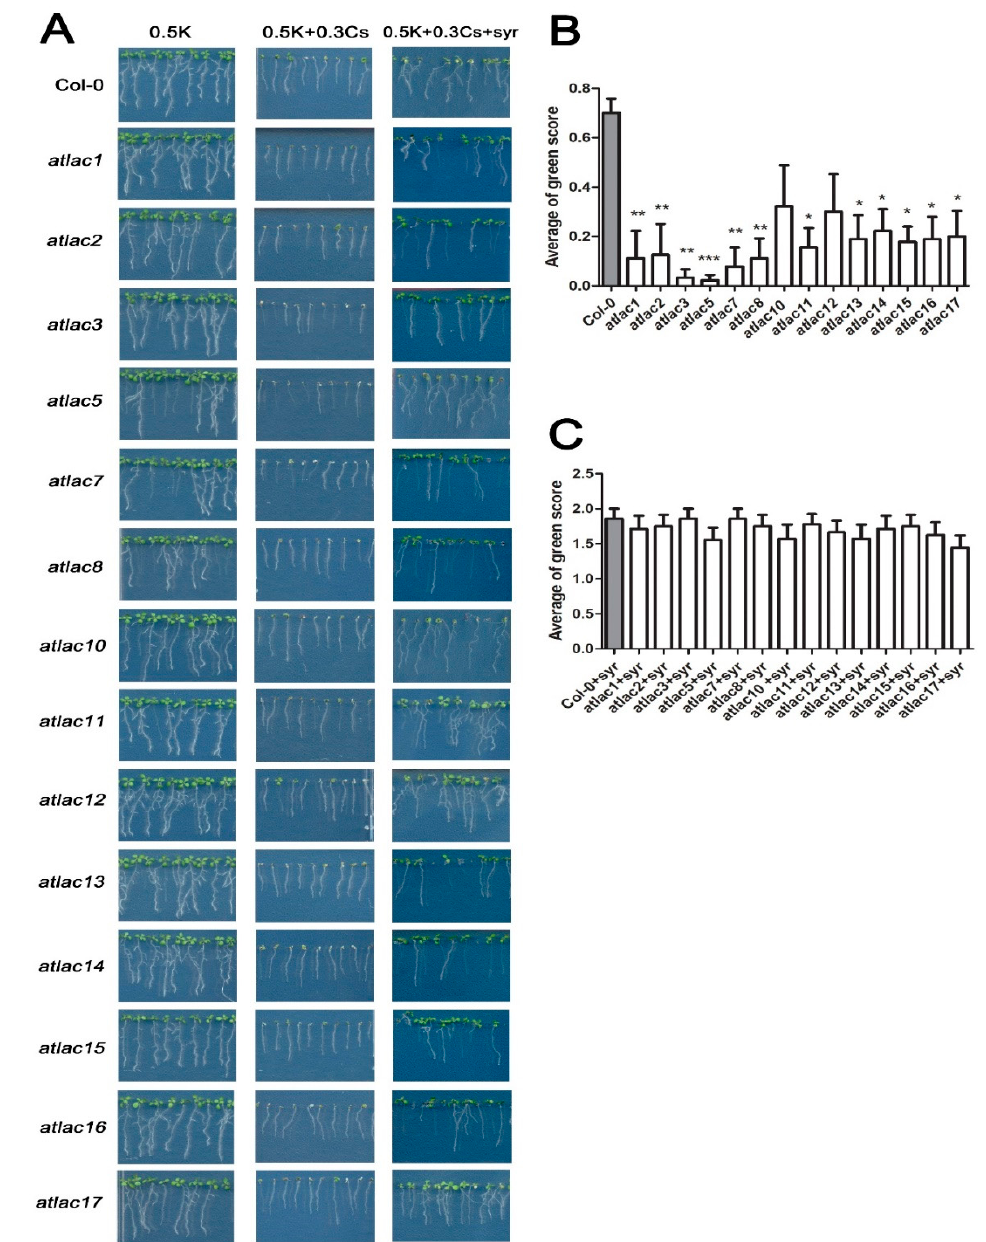
Figure 6. Response of Arabidopsis laccase mutants ( atlacs ) to cesium treatment. ( A ) A series of atlacs were grown on media containing 0.5 mM potassium (K) and 0.3 mM cesium (Cs) with or without the addition of 100 μ M syringic acid (syr). Average green score for atlac mutants and Col-0 wild-type plants after 8 days of growth on media containing 0.3 mM cesium ( B ) and 0.3 mM cesium and syringic acid ( C ). Statistically significant differences between the mutant lines compared to control plants (Col-0) were determined by a Kruskal–Wallis test with Dunn’s multiple comparison post-test (* for p < 0.05, ** for p < 0.01, *** for p < 0.001). Error bars represent the SE ( n > 60).